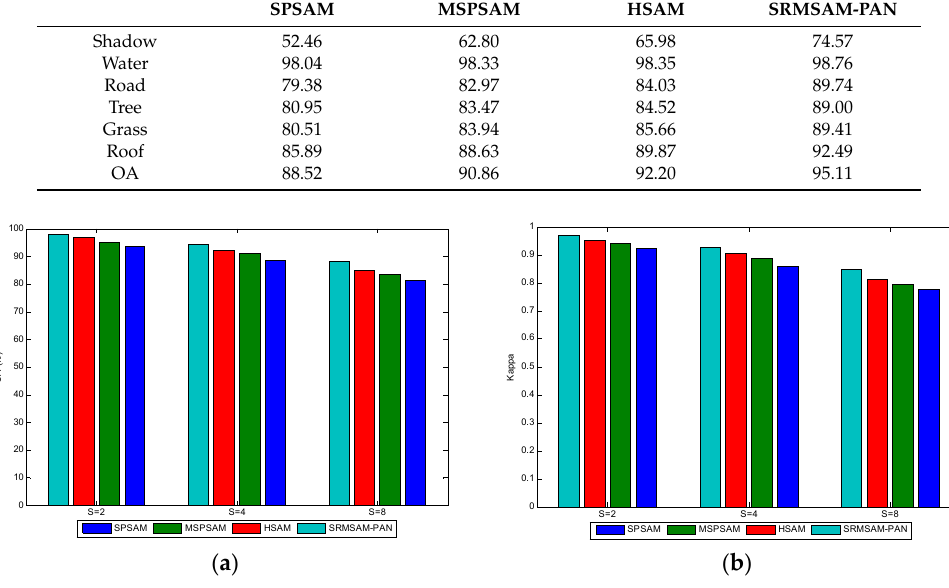
Figure 11. ( a ) Overall accuracy (OA (%) of the four methods in relation to the zoom factor S . ( b ) Kappa coefficient (Kappa) of the four methods in relation to the zoom factor S .